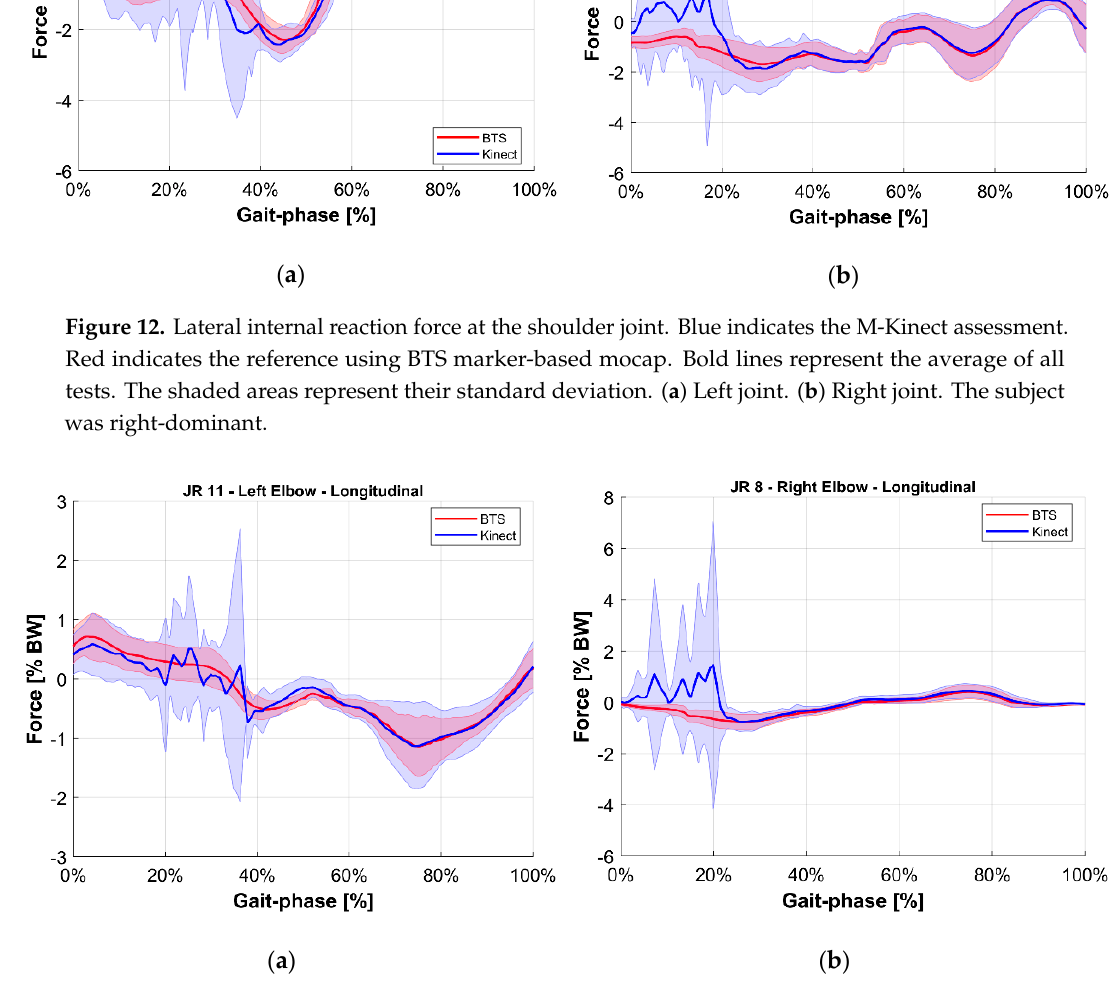
Figure 13. Longitudinal internal reaction force at the elbow joint. Blue indicates the M-Kinect assessment. Red indicates the reference using BTS marker-based mocap. Bold lines represent the average of all tests. The shaded areas represent their standard deviation. ( a ) Left joint. ( b ) Right joint. The subject was right-dominant.